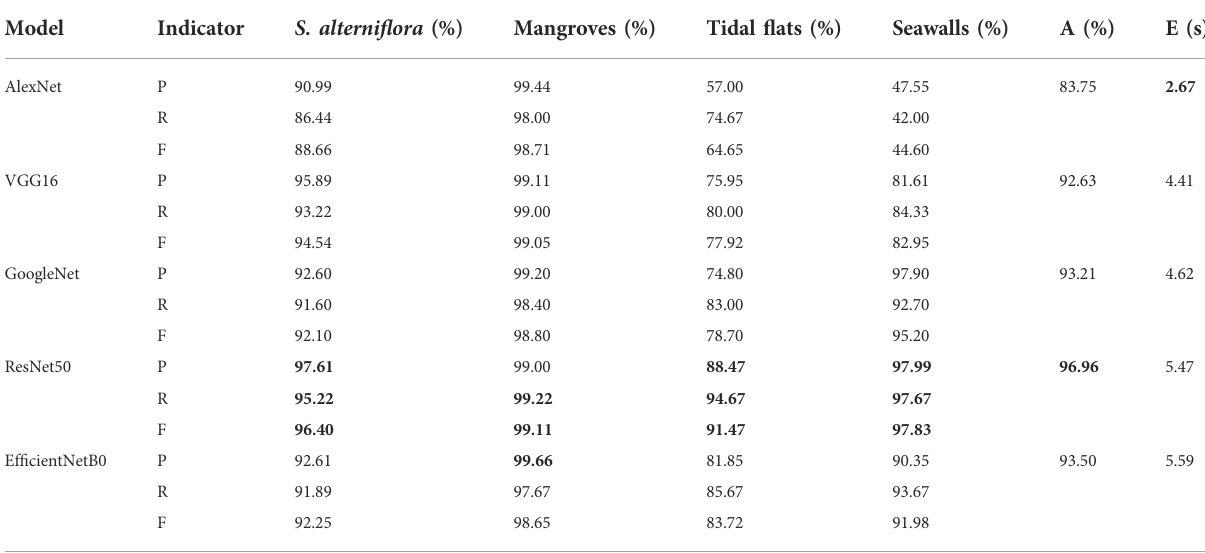
TABLE 2 Test results of fi ve CNN